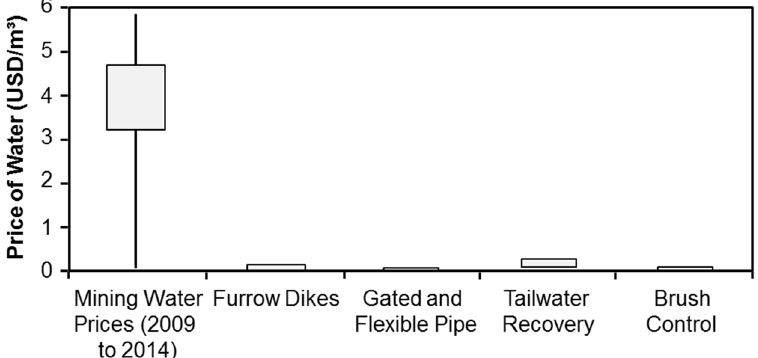
Figure 11. The price of water varies per Best Management Practice (BMP), but all water conservation measures cost less than the wholesale price of water for hydraulic fracturing in Texas. The box plot of water price shows the 1st and 3rd quartiles within the boxes. The lines extending beyond the box, or whiskers, show the data outside of those quartiles. The price paid for mining water does not include transaction costs which vary regionally. (Figure created by the authors based on analysis and data from private operators and [12,24,49—67].)